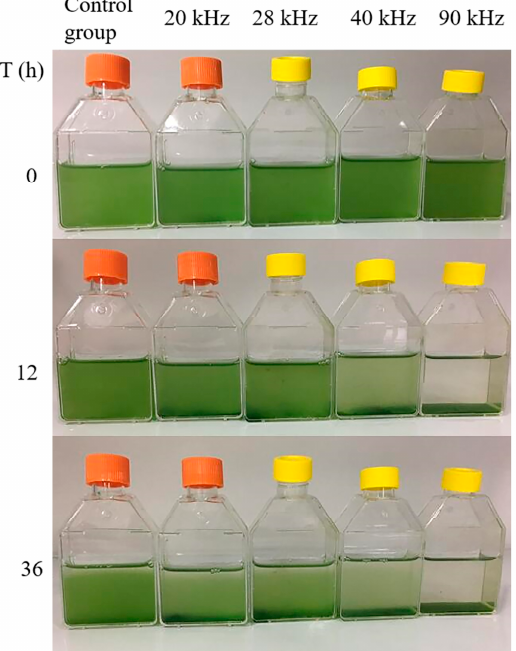
Figure 2. Growth of M. aeruginosa after treatment for 5 min at different ultrasonic frequencies.